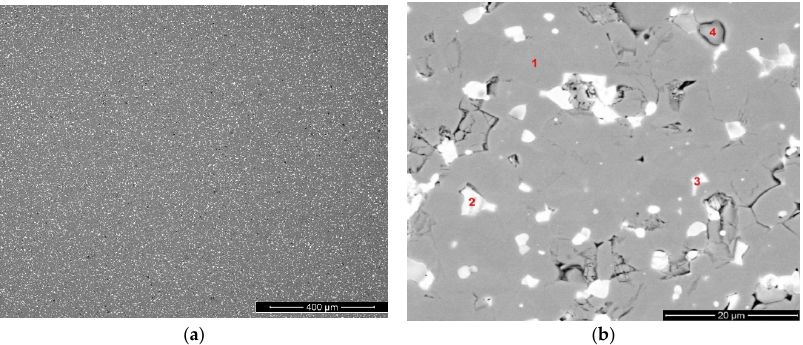
Figure 2. ( a , b ) Microstructure (SEM image, BSED) of Nd-Pr-Dy-Fe-B magnet prepared by recycling. Table 2. Chemical compositions (at.%) of phases present in the recycled Nd-Pr-Dy-Fe-B magnet. Element/Phase O